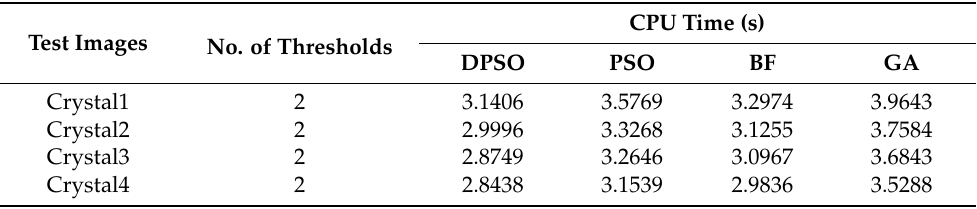
Table 7. Comparative analysis of average CPU time obtained by the DPSO-based method with other bio-inspired multilevel thresholding